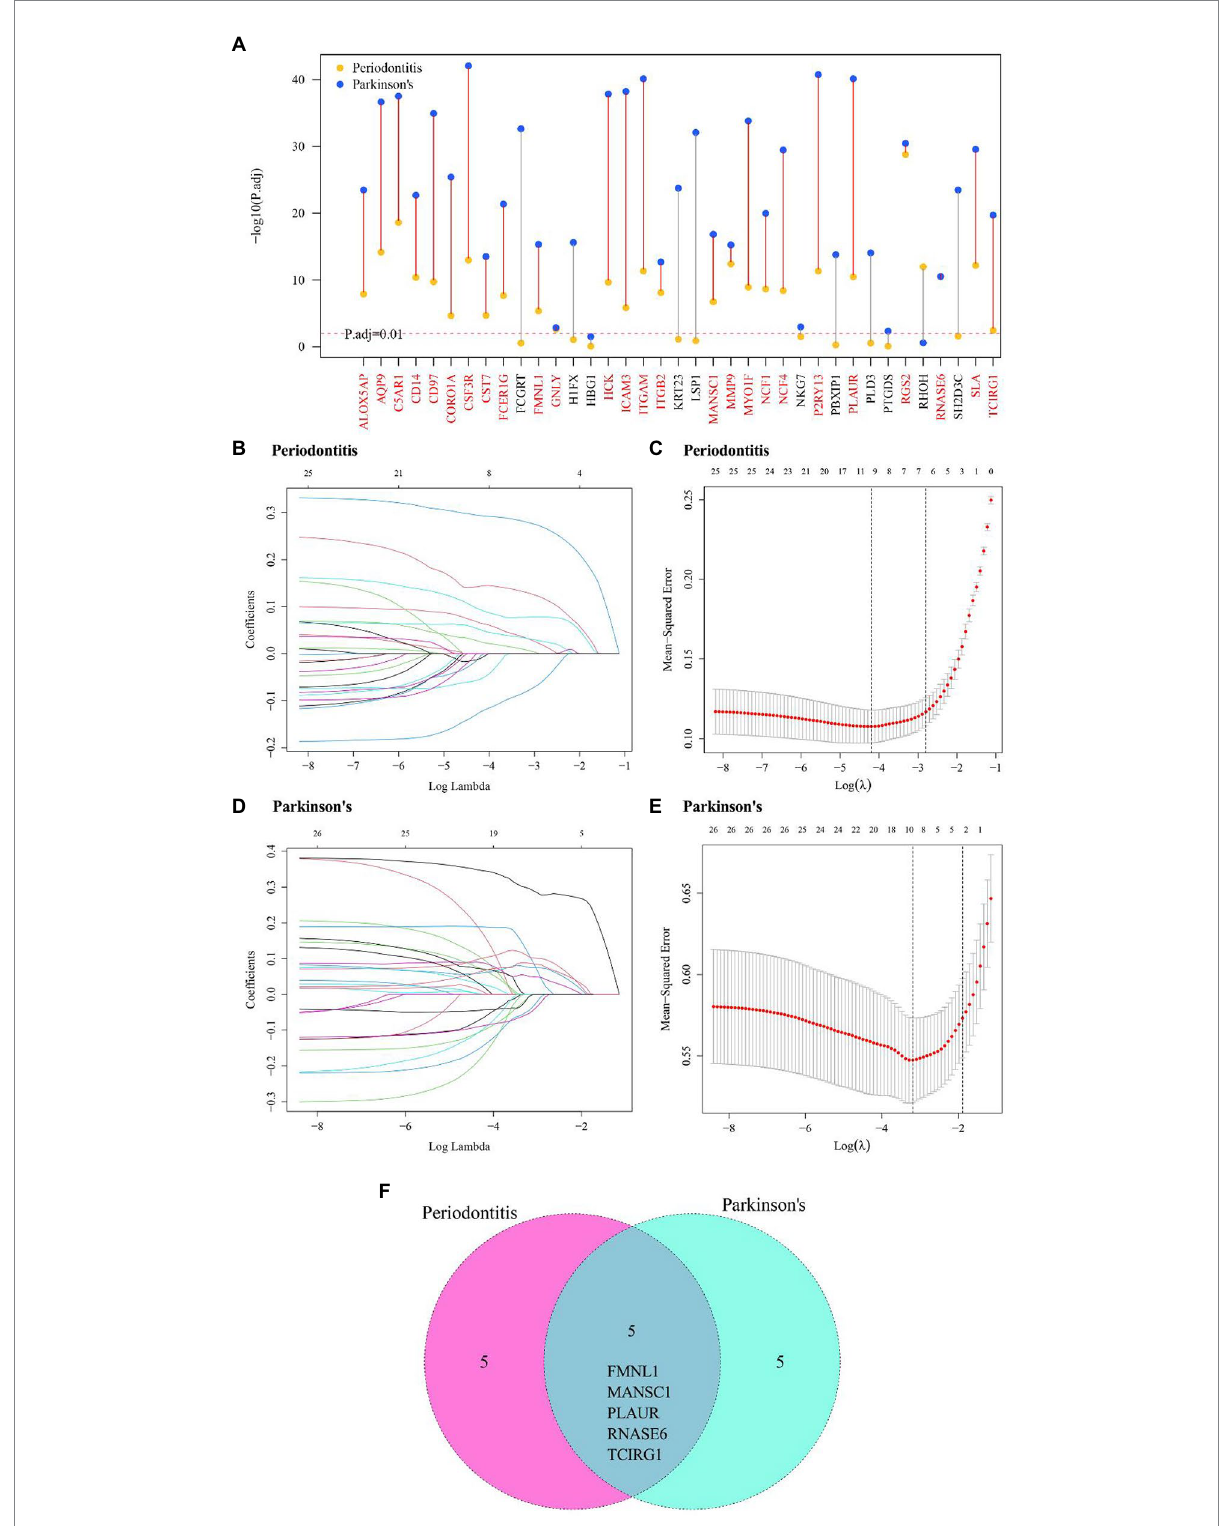
FIGURE 8 Hub cross-talk gene screening. (A) DE-cluster cross-talk gene of periodontitis and Parkinson’s disease’s. (B–D) Results of LASSO analysis for periodontitis and Parkinson’s disease. Each line in the graph represents a gene, and a larger value of the log lambda as the gene tends to 0 indicates that the gene is more critical. (C–E) cross-validation results of Periodontitis disease and Parkinson’s disease model. (F) Periodontitis disease and Parkinson’s disease’s hub cross-talk